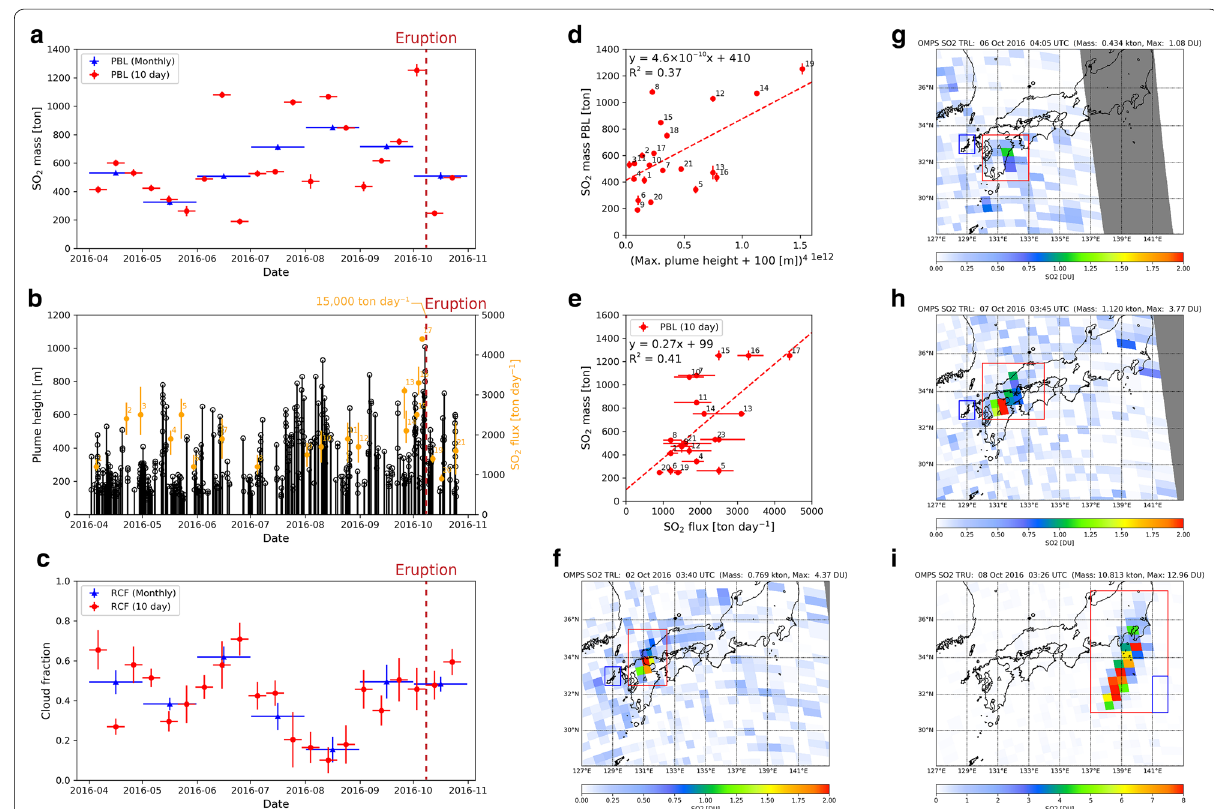
Fig. 5 a The time-averaged (10-days and monthly) SO 2 PBL mass emitted by the passive degassing of Aso volcano estimated by OMPS. b Time series of the plume height (black line, from Fig. 2) and SO 2 flux (orange point). The SO 2 flux data are measured by car traverses by JMA (http://www. data.jma.go.jp/svd/vois/data/fukuo ka/rovdm /Asosa n_rovdm /gas/gas.html). The error bars correspond to maximum and minimum SO 2 fluxes obtained by multiple traverses. The text “15,000 ton day − 1 ” shown in the upper part corresponds to the SO 2 flux measured on 7 October 2016. c The time-averaged (10-days and monthly) and spatial-averaged cloud fraction of the OMPS data in the volcanic region (red rectangle in Figs. 3 and 4). d Correlation plot of the 10-days averaged SO 2 PBL mass against the fourth power of the maximum plume height for the corresponding period. The plume height values are converted to those above the crater bottom ( plume height in Fig. 2 100 m, see text). A number on the right shoulder = + of each point correspond to the period number shown in Fig. 3. e Correlation plot of the 10-days averaged SO 2 PBL mass against the SO 2 flux for the corresponding period. A number on the right shoulder of each point correspond to the SO 2 flux number shown in Fig. 5b. f – i Daily map of SO 2 VCDs of f TRL on 2 October, g TRL on 6 October, h TRL on 7 October, and i TRU on 8 October 2016. The triangle and the red and blue rectangles in f–i are as same as those in Fig.